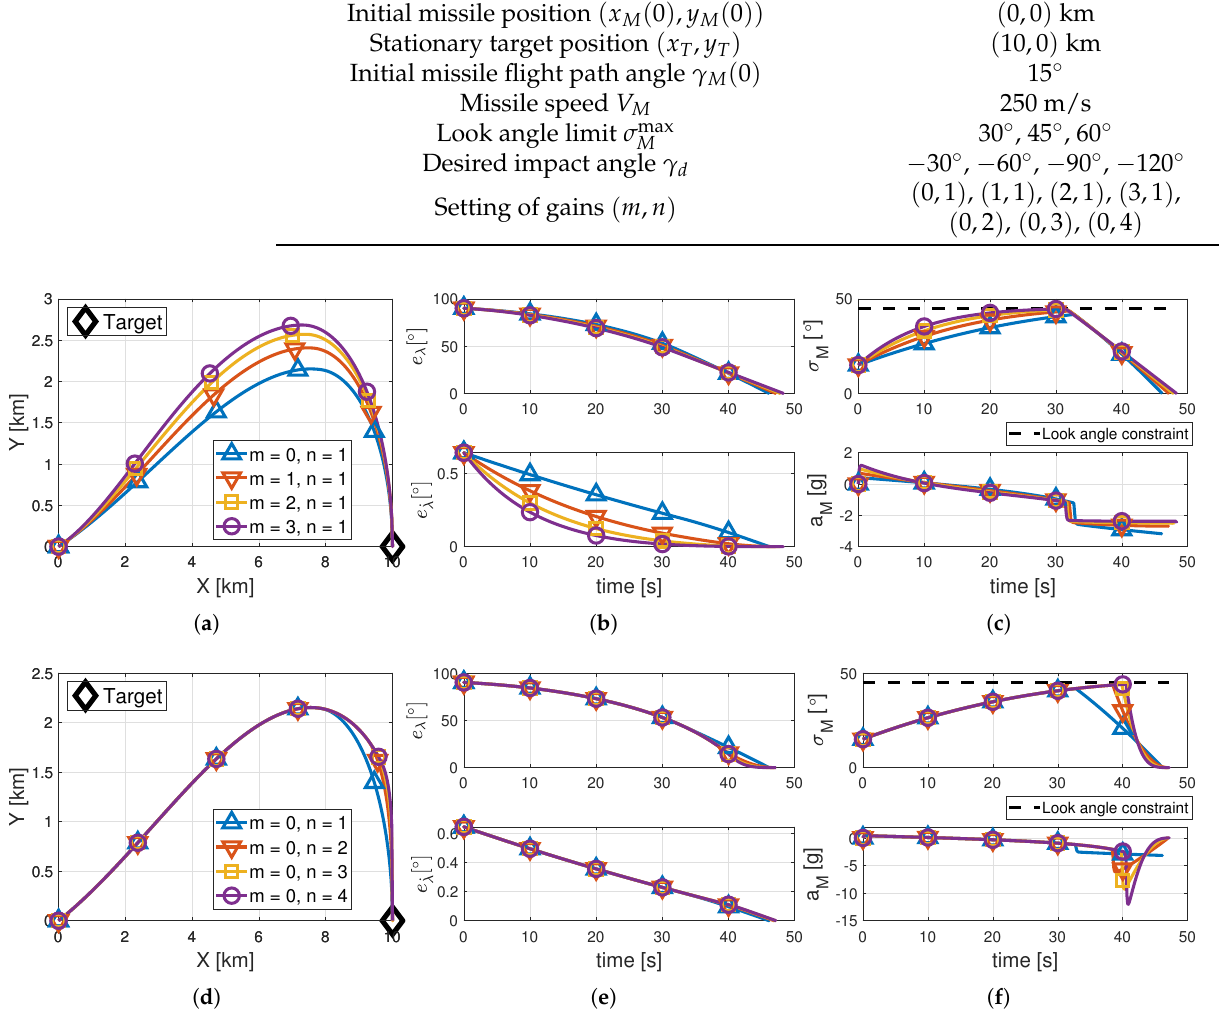
Figure 2. Simulation results of the proposed law under various setting of gains. ( a ) Flight trajectories. ( b ) Error variables. ( c ) Look angles and normal accelerations. ( d ) Flight trajectories. ( e ) Error variables. ( f ) Look angles and normal